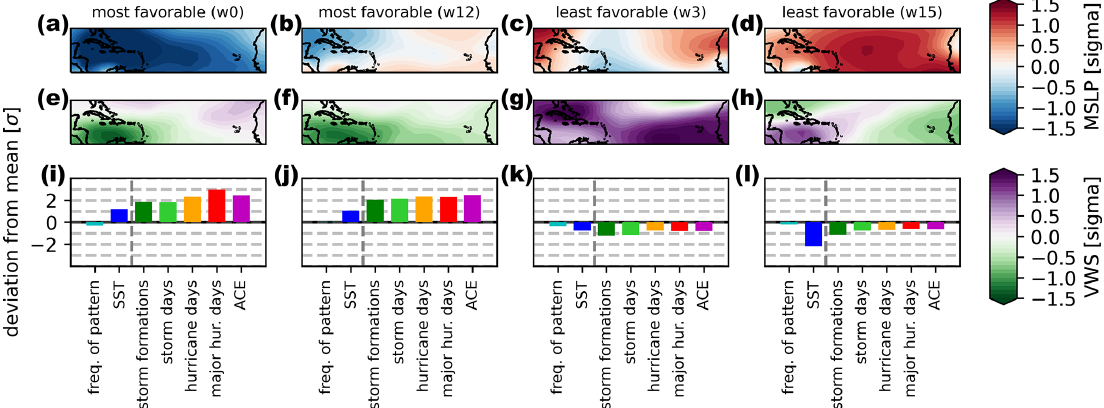
Figure 1. Tropical cyclone activity during selected weather patterns. Mean sea level pressure anomalies (a–d) and vertical wind shear anomalies (e–h) for four selected weather patterns w0, w12, w3 and w15. The last row (i–l) shows relative deviations from the average of all weather patterns expressed in standard deviations for the following statistics: frequency of the weather pattern, SST in the MDR, number of storm formations during the weather pattern, storm days, hurricane days, major hurricane days and average ACE generated during days with this weather pattern. A value of 2 indicates that the statistic is 2 standard deviations higher during this weather pattern than for the average over all weather patterns. All 20 weather patterns are shown in Figs. S1, S2 and S3.